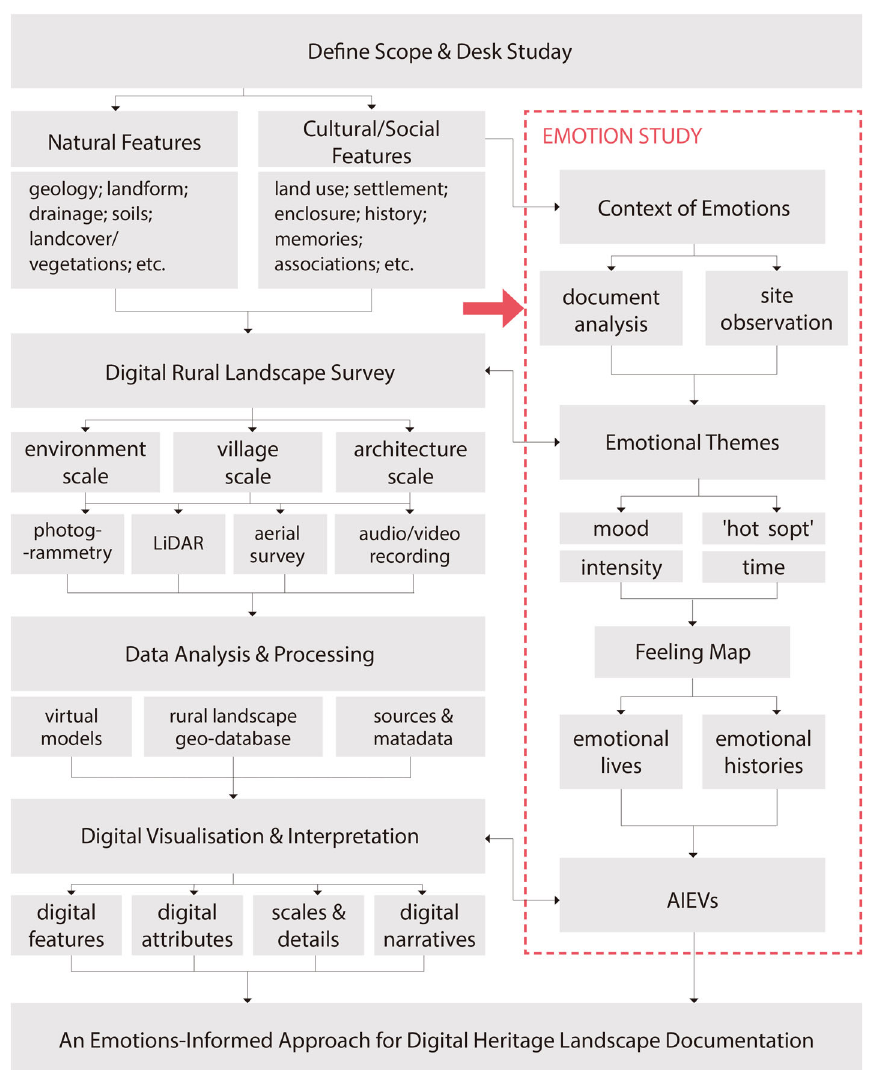
Fig. 3 A heritage documentation process with an emotion study before digital survey (Source: the